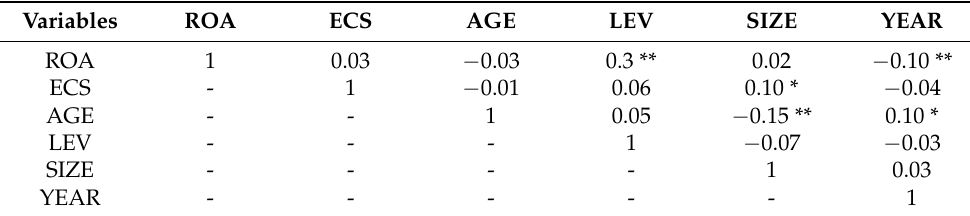
Table 5. Correlation analysis between variables